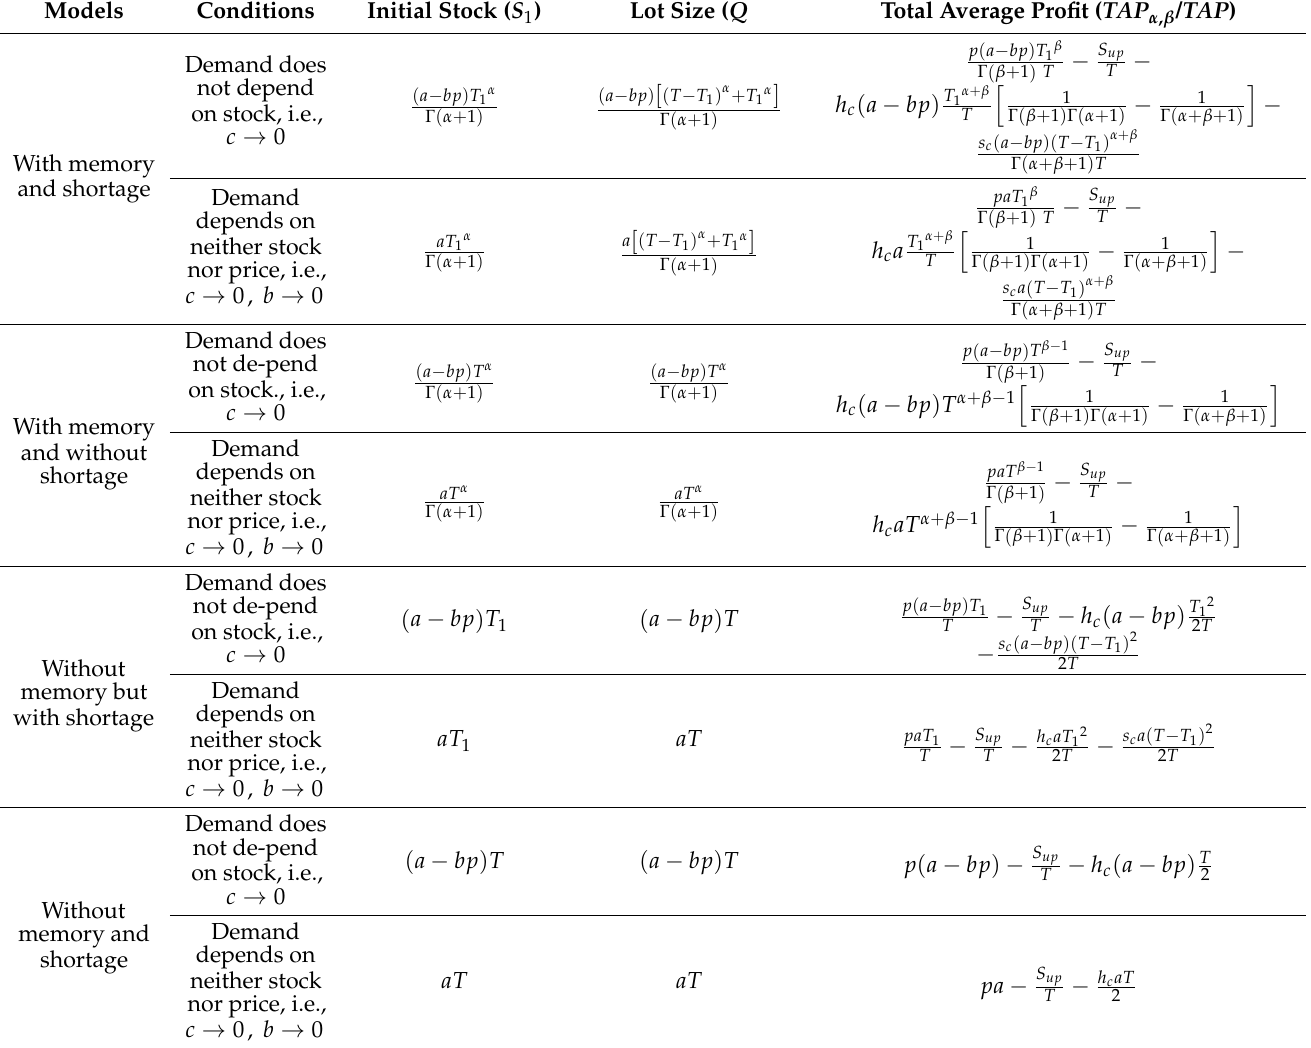
Table 3. Different existing economic order quantity models in literature as particular cases of the proposed model in this